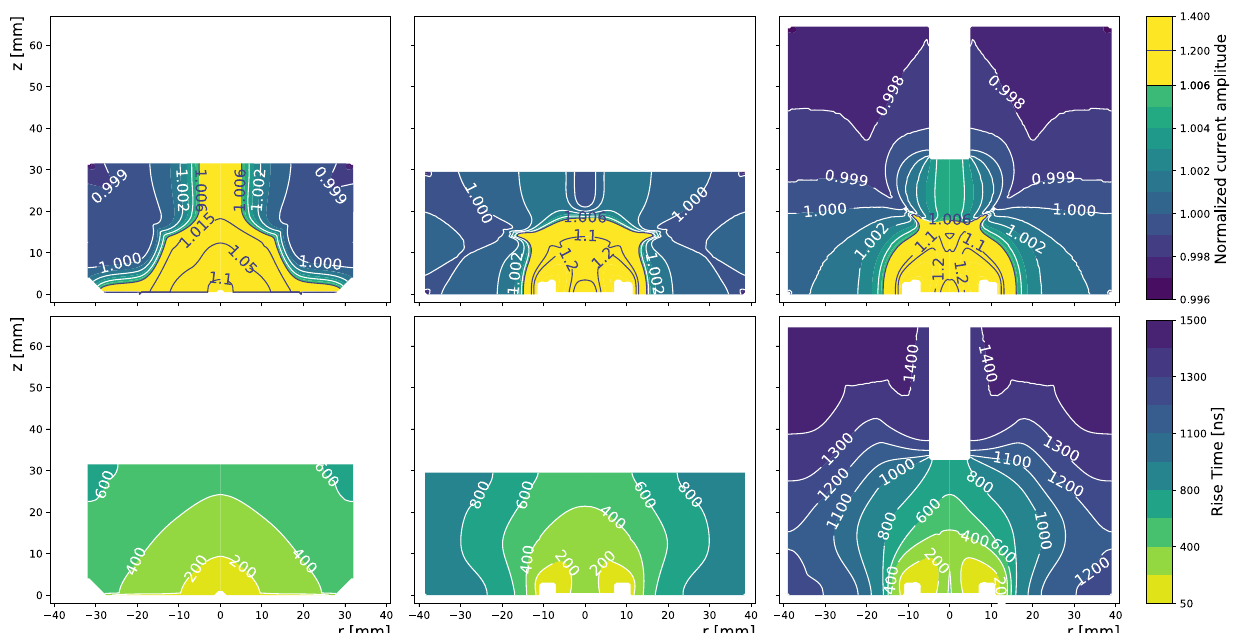
Fig. 4 A / E (top) and rise time (bottom) values for the three analyzed geometries. In PPC and BEGe detectors rise times range up to 600-800 ns, while for inverted coaxials they can be twice as big, and saturate for